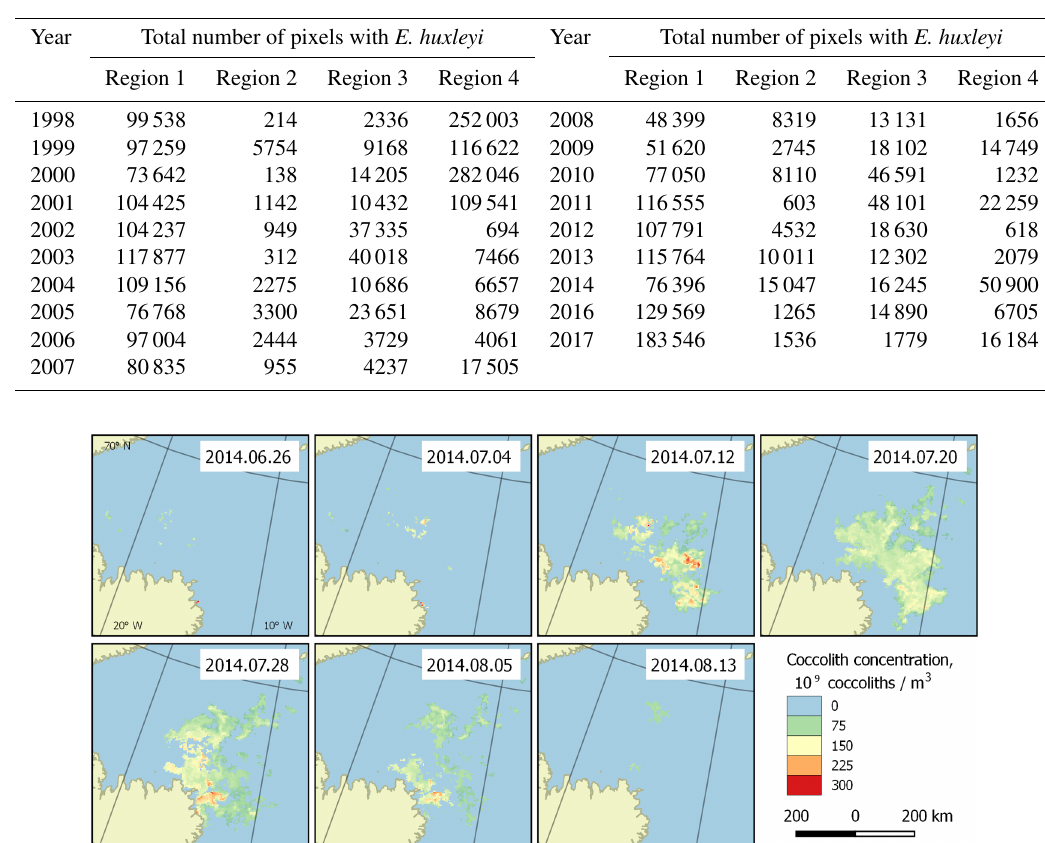
Table 2. Total number of identified pixels with E. huxleyi for each blooming season in the period 1998–2016 within the four regions.